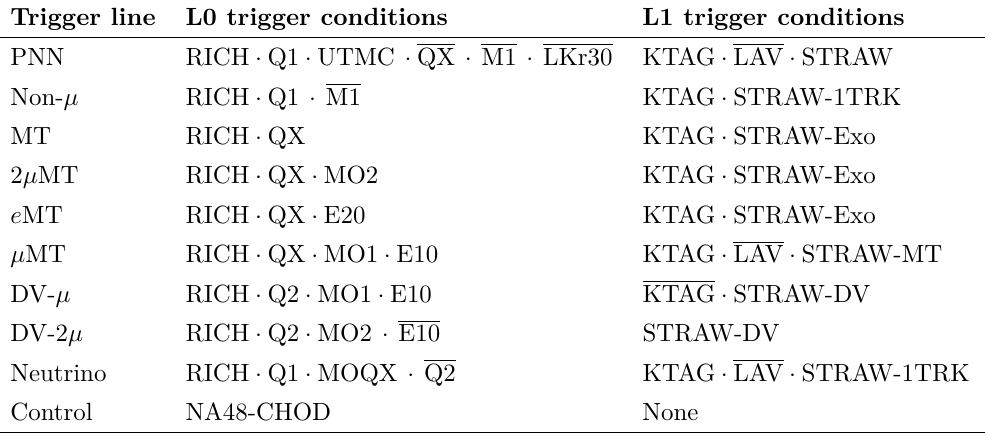
Table 2. K + trigger lines and the corresponding L0 and L1 trigger conditions. An overline indicates that the condition is used in veto.